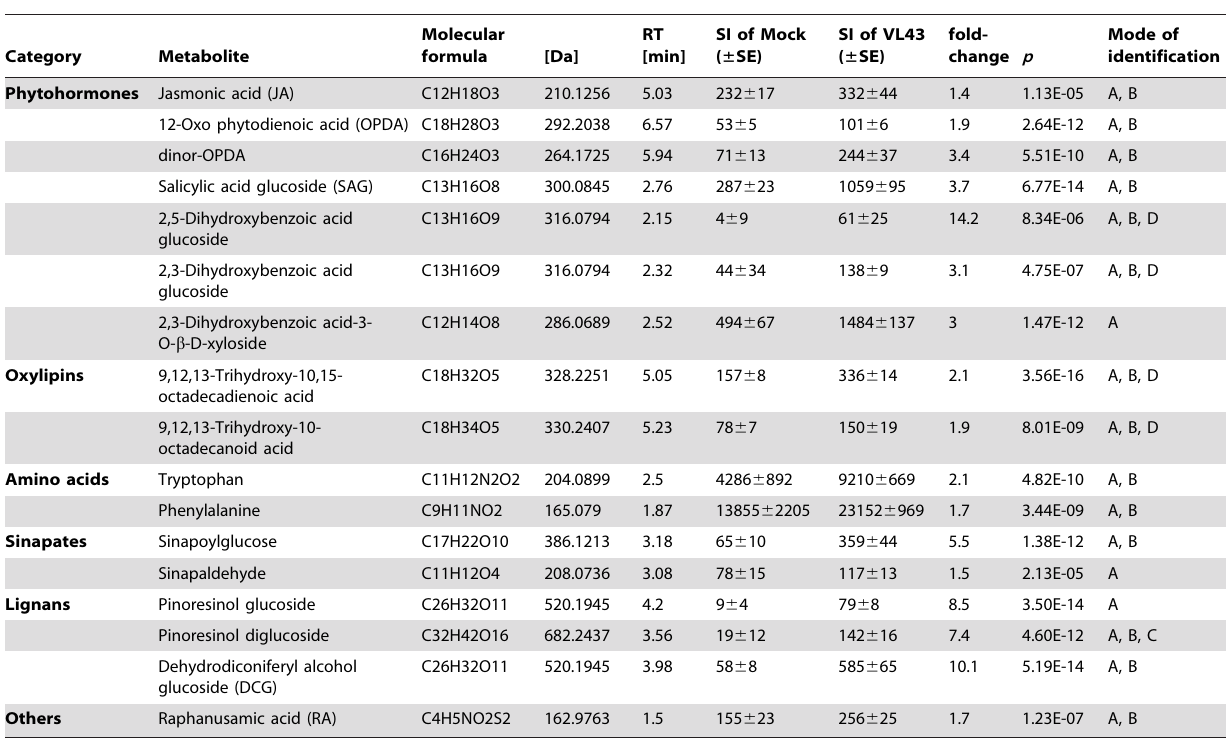
Table 6. Infection markers identified in leaves of the apoplast of Arabidopsis thaliana infected with Verticillium longisporum VL43.